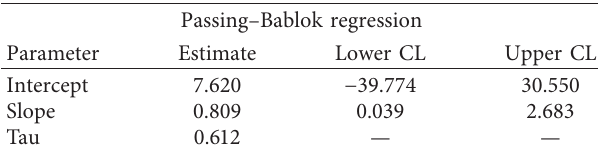
Figure 4: (a) RMSE PRESS plot for PPO as a function of the number of factors. (b) Method comparison-regression analysis: regression analysis: PPO predicted by PLS vs. PPO measured by the gold standard method. The dashed grey line: a line of equality, solid red line: result of the Deming regression with the obtained fit ratio, and solid blue line: a line of Passing–Bablok regression. Table 1: Analysis details of the Passing–Bablok regression.